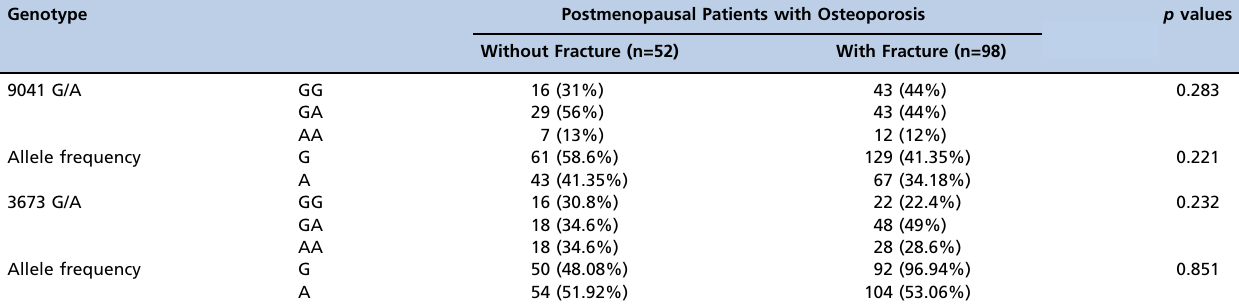
Table 2 - 9041 G/A and 3673 G/A genotype and allele frequency distribution in postmenopausal osteoporosis patients with and without fracture. Genotype